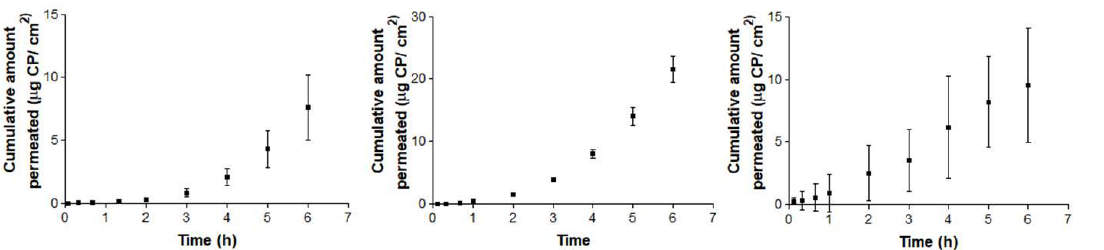
Figure 5. Ex vivo conjunctiva buccal (left), sublingual (center) and vagina permeation (right) profiles of CP over 6 h, expressed by mean ± SD of six replicates ( n = 6). Permeation parameters for ophthalmic membranes are summarized in Table 2. Table 2. Median, maximum and minimum values of flux (Js), lag time (Tl) and permeability coefficient (Kp) of CP at 6 h from CP saturated solution (CP-Sat) through ophthalmic tissues (conjunctiva, cornea and sclera).